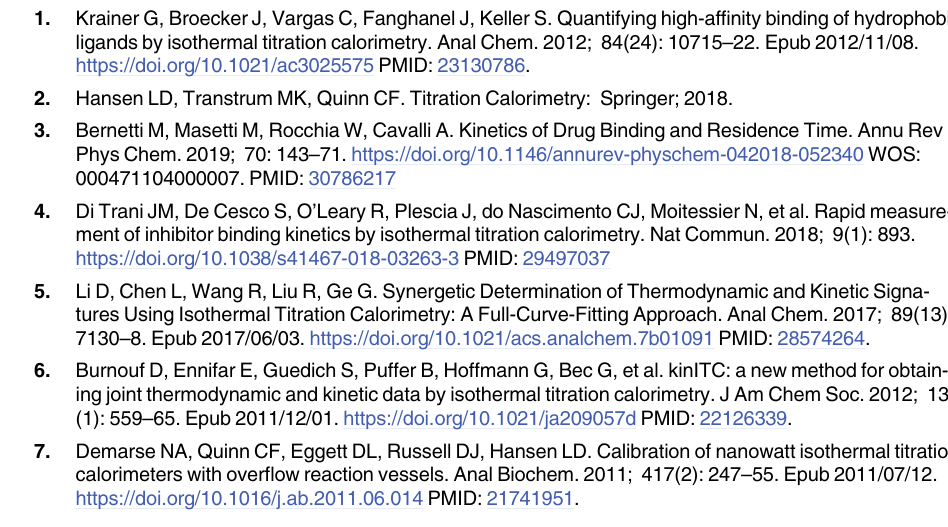
S1 Fig. The influence of injection volume error on the heat residual distribution with dif- ferent K . The left panel shows that when there is an injection volume error ( σ a the simulated standard deviation of heat residual (SDR) increases abnormally in the transition region; the right panel shows that the simulated SDR decreases monotonically without the injection volume error ( σ = v